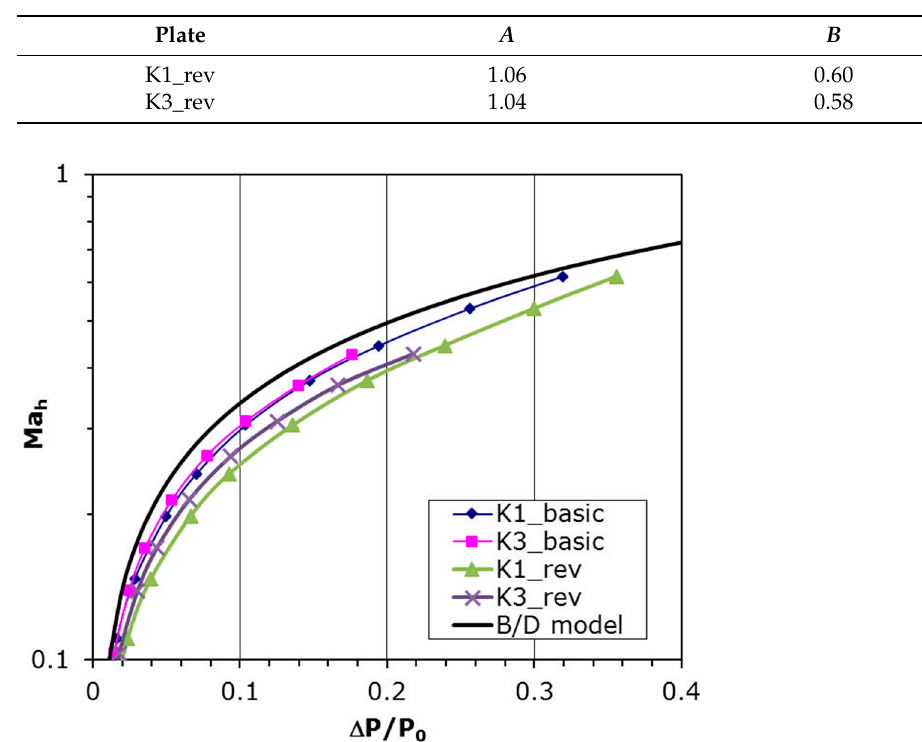
Table 3. Coefficients for the Mach number pressure drop dependency for ‘revised’ plate setting.